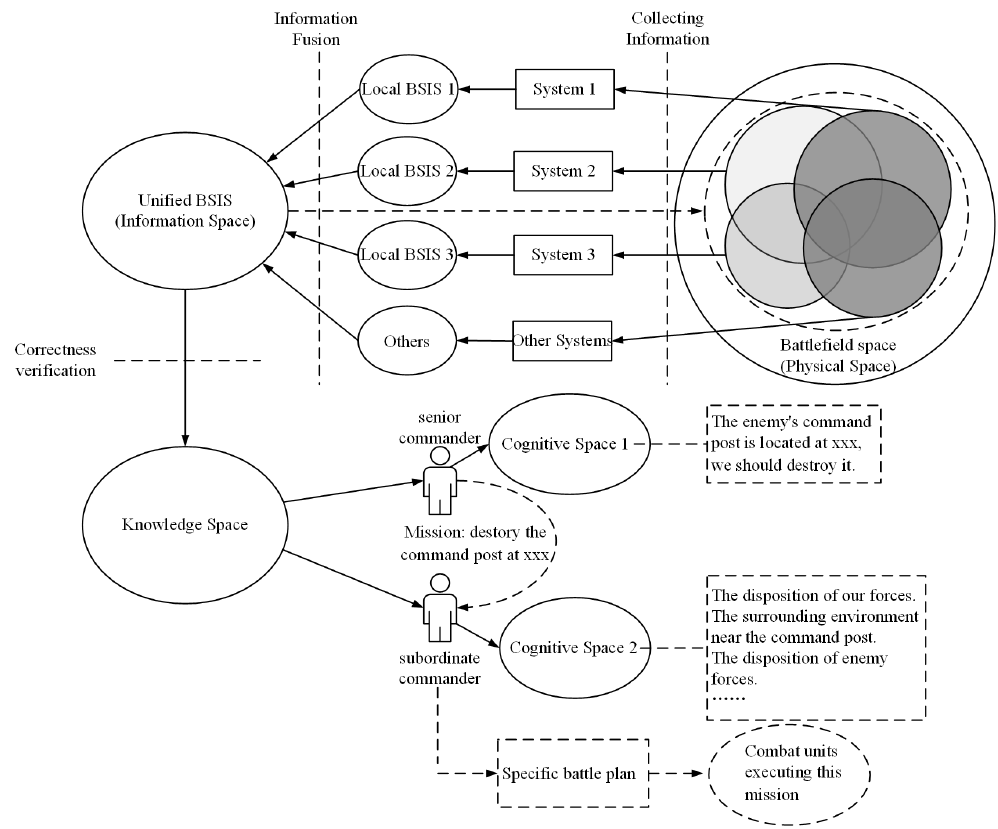
Figure 3. Flow of information based on the unified information